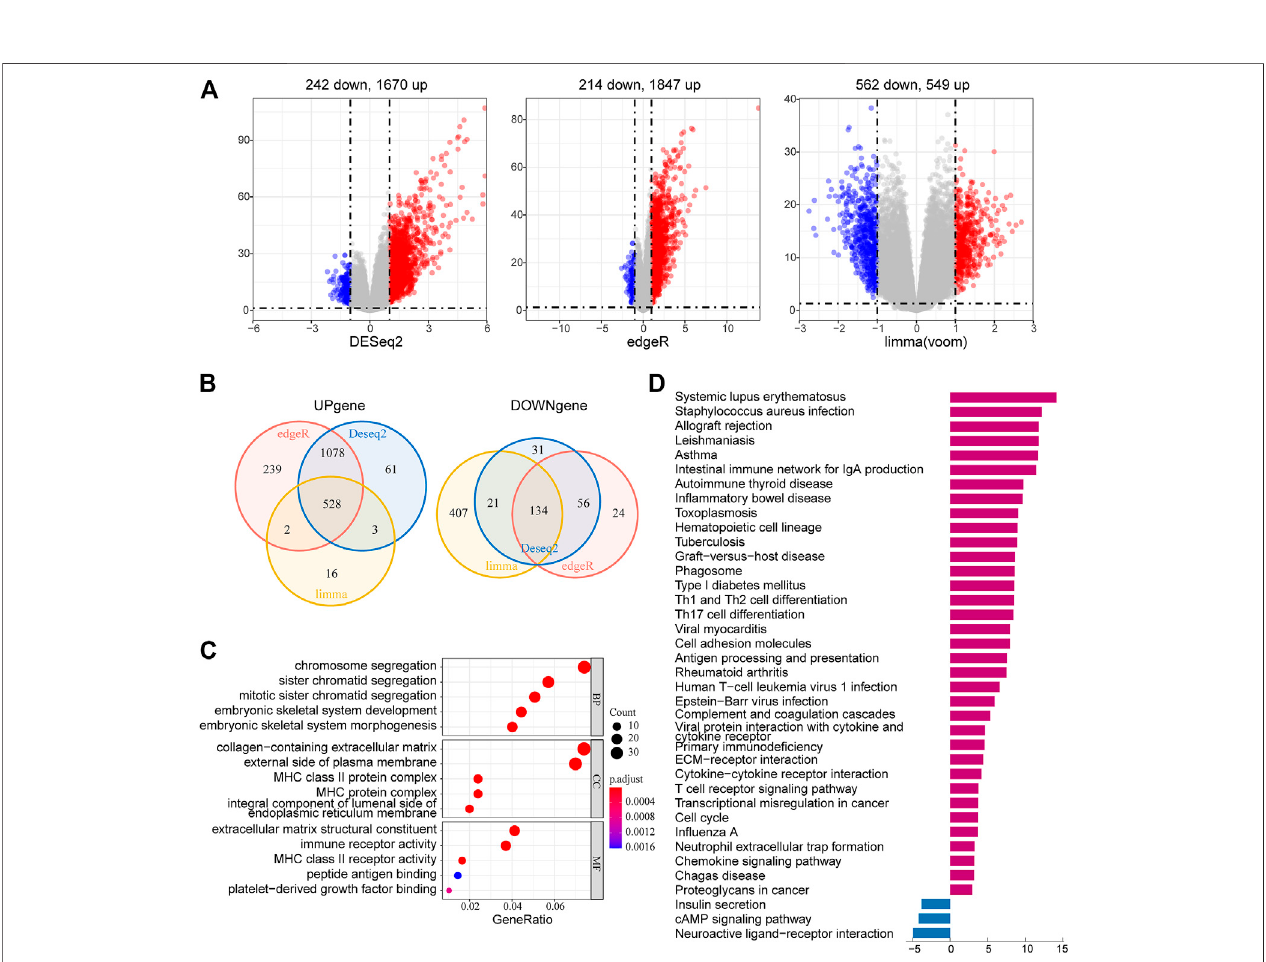
FIGURE 8 | Identi fi cation and functional enrichment analyses of risk-related DEGs. (A) Volcano plot of risk-related DEGs between the high-risk group and low-risk groupidenti fi edusingedgeR,limma,andDESeq2algorithms,withthecut-offcriterion p < 0.05and|log 2 FC| ≥ 1.Bluedots:signi fi cantlydownregulatedgenes;reddots: signi fi cantly upregulated genes. (B) Venn diagram of the overlapping risk-related DEGs screened by the three differential expression analyses. (C) GO analysis of risk- related DEGs with three terms biological processes, cellular components, and molecular functions (P.adjust < 0.05). (D) KEGG pathways enriched in the upregulated and downregulated risk-related DEGs (P.adjust <